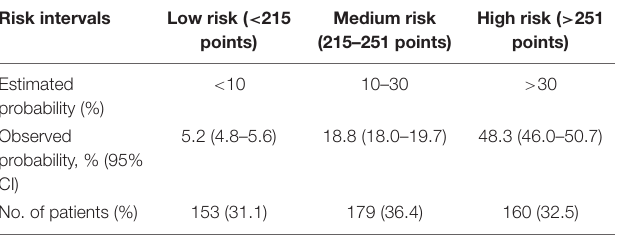
TABLE 3 | Risk intervals of severe hypoxemia based on the nomogram and clinical practice. Risk